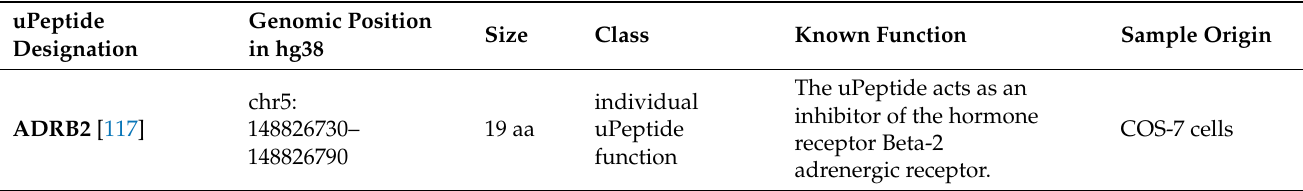
Figure 2. Mechanisms of ribosome stalling-mediated translational regulation. ( A ) Under physiological conditions, ribosomes may scan through the uORF start codon (leaky scanning) or reinitiate at the CDS after translating the uORF, maintaining normal CDS translation and cellular homeostasis. ( B ) Interaction of the nascent peptide with small molecules, metabolites or other molecular interactors may induce ribosome stalling, preventing ribosomal reinitiation, and leading to transcript degradation via nonsense-mediated decay (NMD). ( C ) Mutation-associated introduction of a new uStop codon within the uORF sequence may lead to ribosome stalling and can prohibit downstream translation, indicated by the crossed out arrow. Table 3. Examples of functional uPeptides in